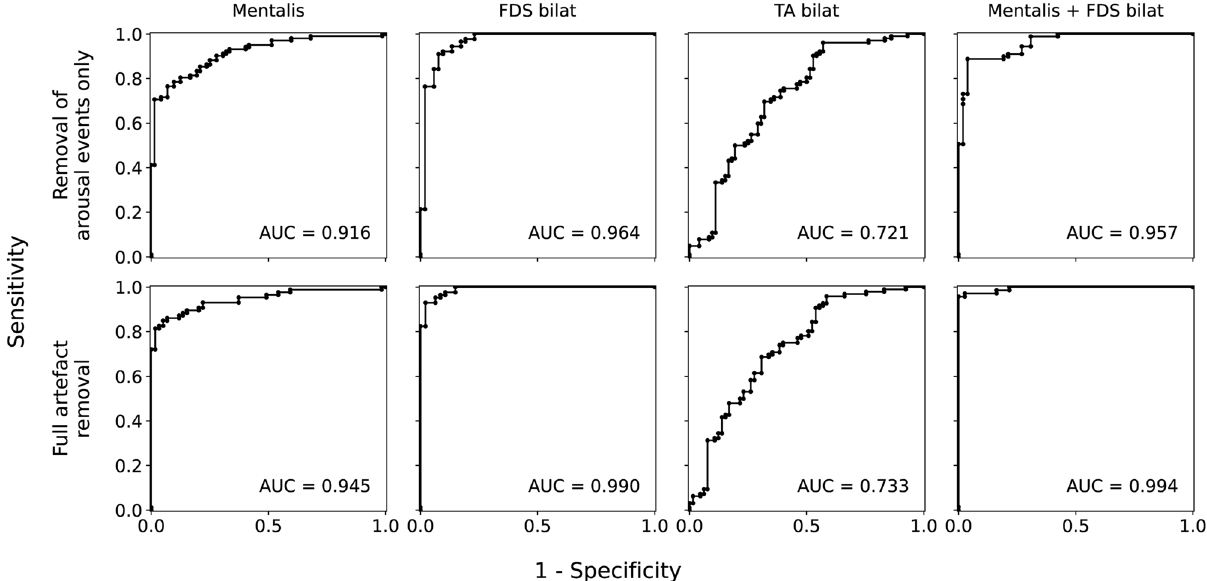
Figure 3. Receiver operating characteristic (ROC) curves of selected electromyography channels: from left to right: mentalis, any; flexor digitorum superficialis (FDS) bilateral (bilat), any; tibialis anterior (TA) bilateral, any; combination of mentalis, any + FDS, any. Upper row provides ROC curves of RBDtector performance after removal of arousals only and lower row provides ROC curves after removal of arousals, snoring and technical artefacts (“full artefact